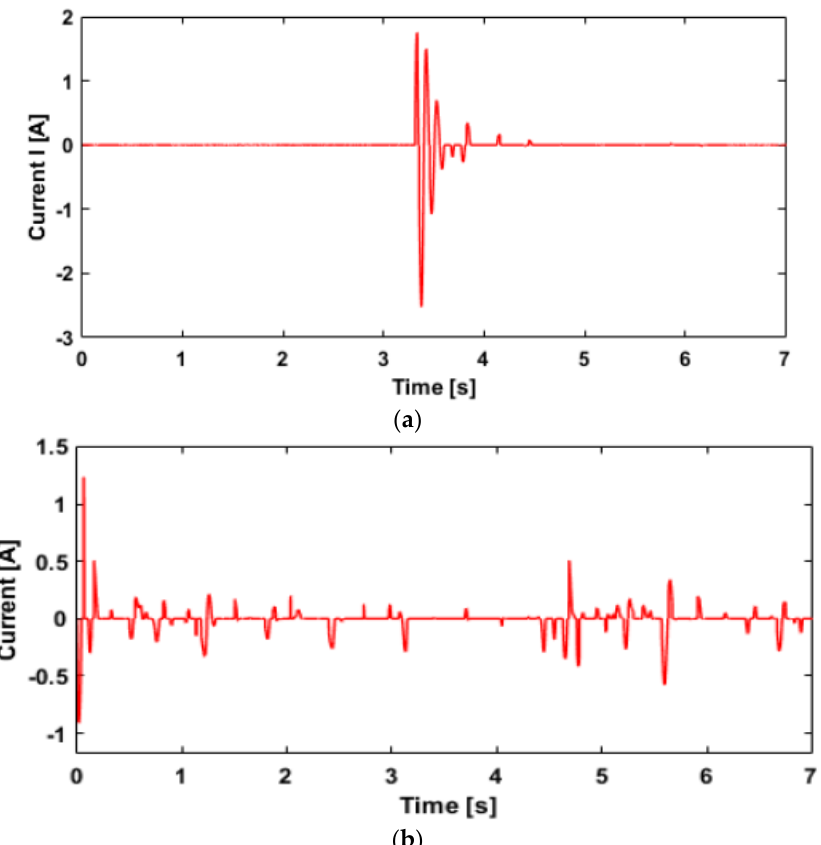
Figure 16. Current input: ( a ) bump road input; ( b ) random road input.